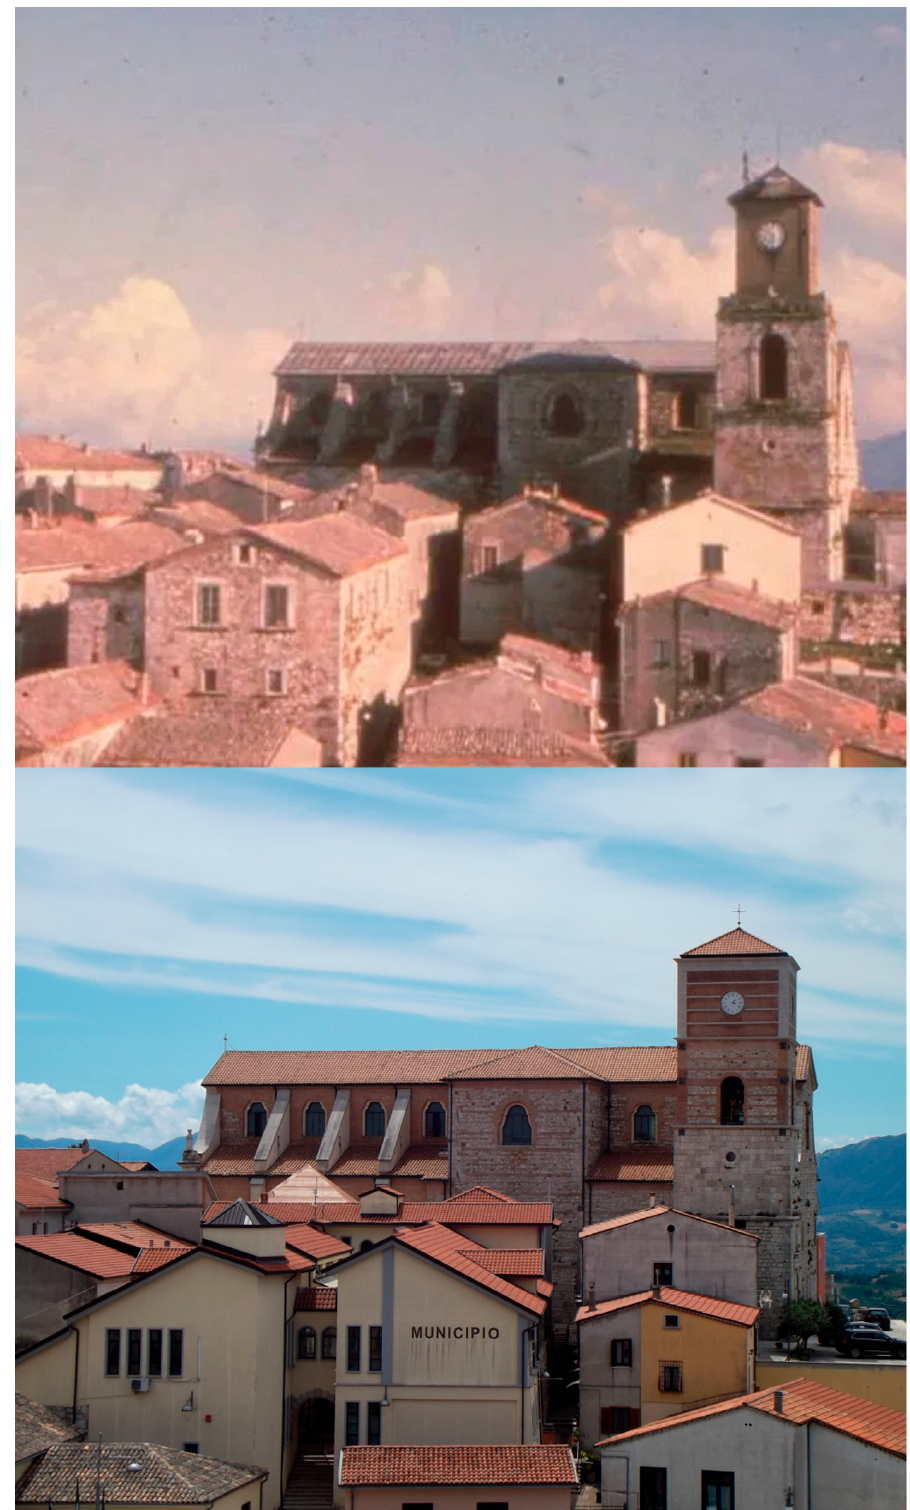
Figure 4. The cathedral of Sant’Angelo dei Lombardi, before (above) and after (below) the earthquake.